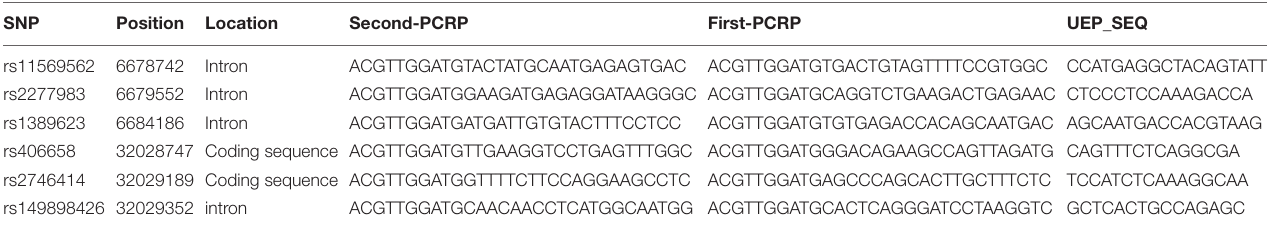
TABLE 2 | Comparison of genotype and allele distribution of 6 SNPs of C3 and C4 gene between FEP and HC. Makers/gene Genotype N